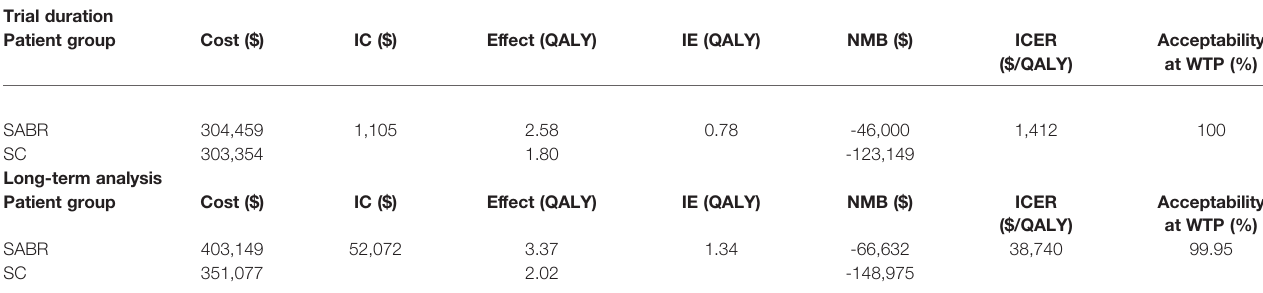
TABLE 2 | Cost-effectiveness analysis results.